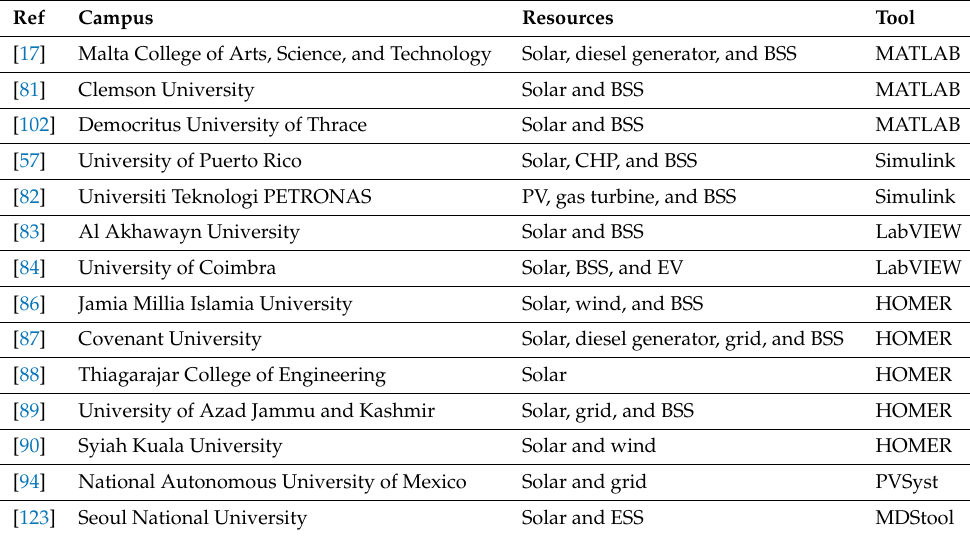
Table 3. Tools used in the campus microgrid energy management